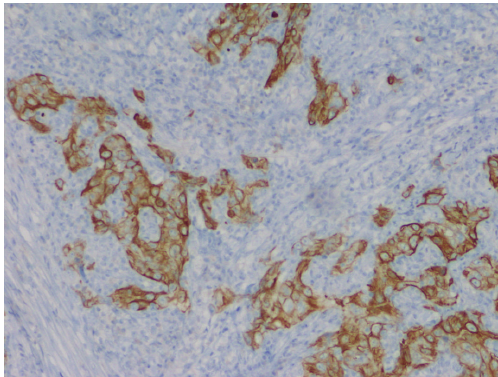
Figure 2: Immunohistochemical staining (100x) positive for CK-